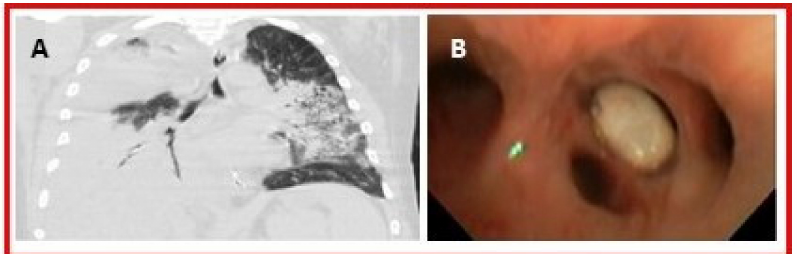
Figure 7. ( A ) Coronal CT of the chest reveals an endobronchial lesion within the right lower lobe bronchus. There is subsequent collapse of the right lower lobe. Other regions of multifocal consolidation are incidentally noted. ( B ) Photograph obtained during bronchoscopy reveals a mass in the right lower lobe bronchus. Histopathology revealed a tophus containing multiple MSU crystals. Adapted